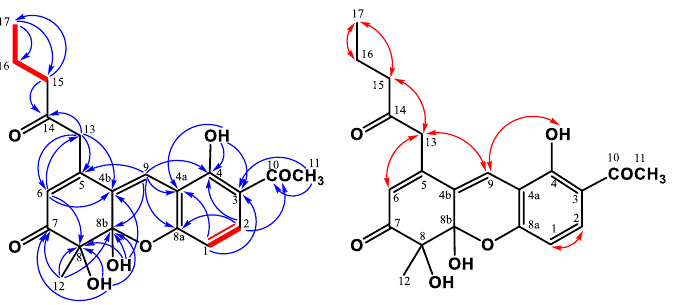
Figure 4. Key 1 H- 1 H COSY ( ━ ), HMBC (H → C), and NOESY (H ↔ H) correlations of 3.